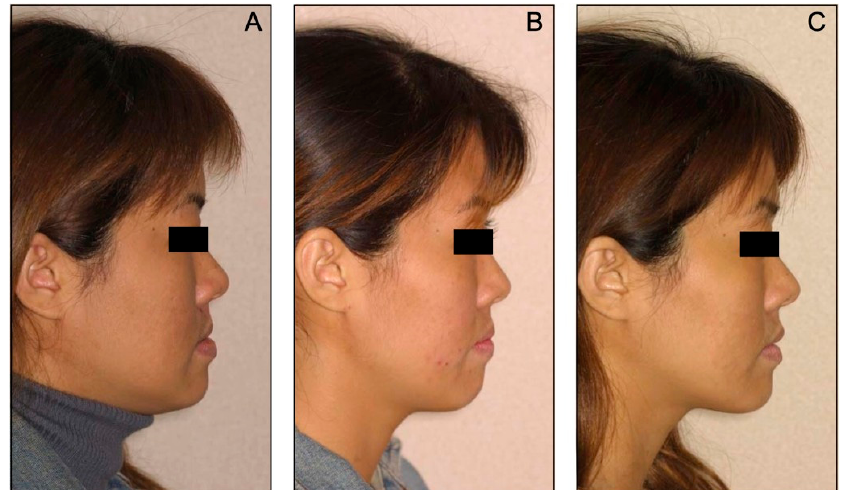
Figure 18. Case 2, profile comparisons. ( A ), Pretreatment; ( B ), Nonextraction approach with the mandibular arch distalization with TSADs; ( C ), Posttreatment with full arch distalization with TSADs on both arches.